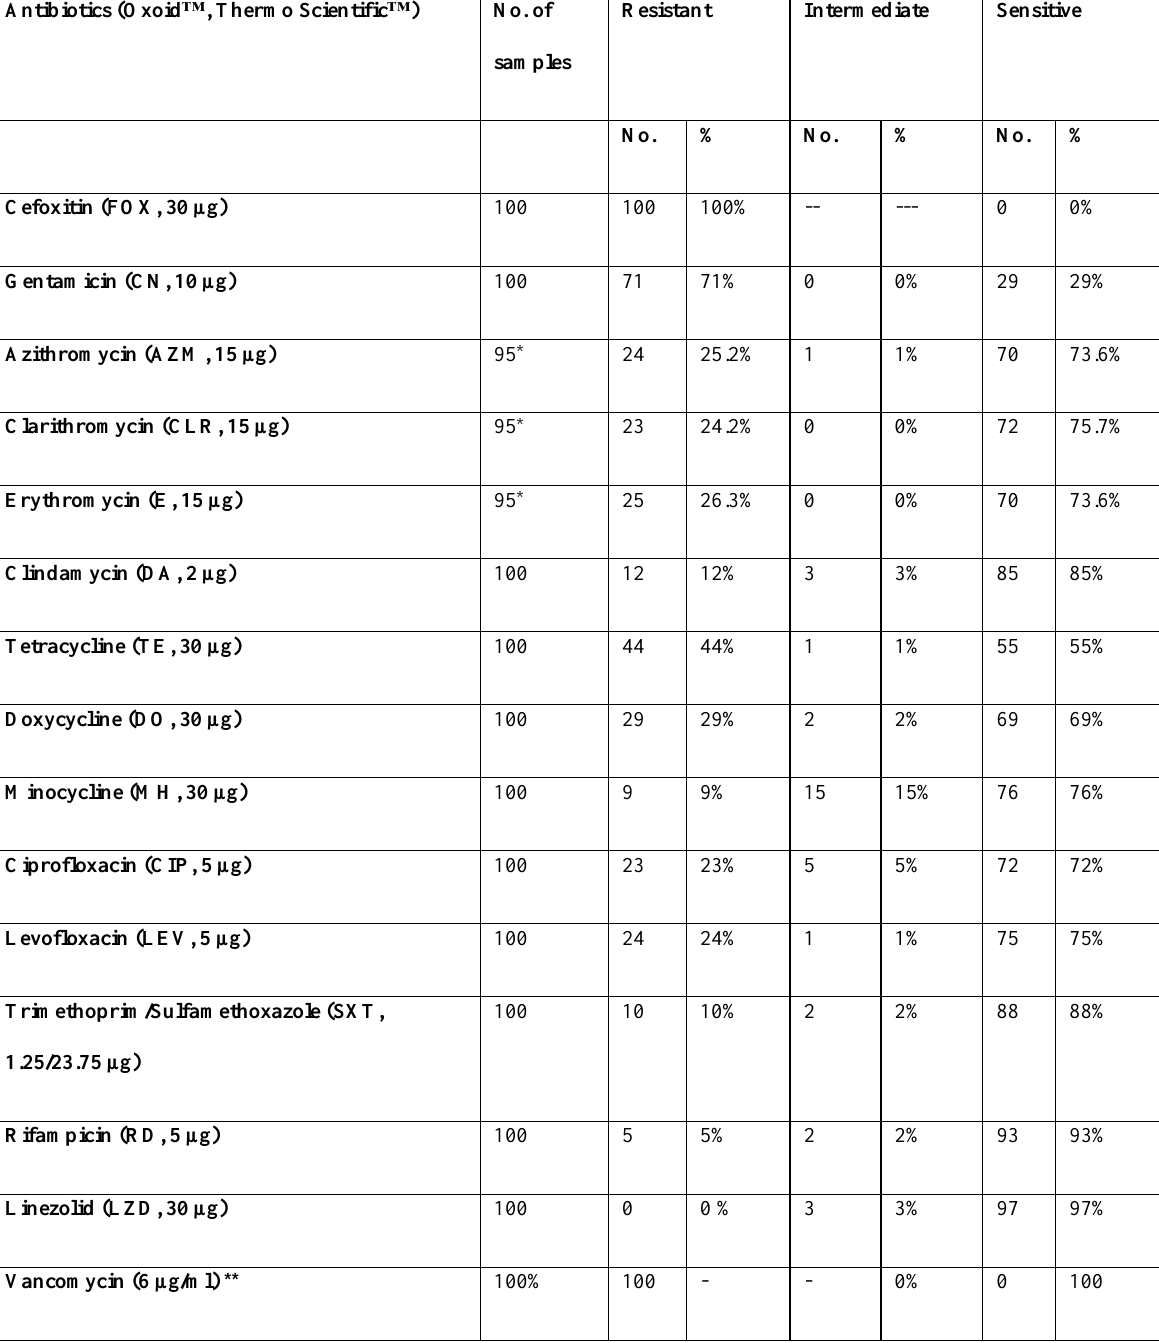
Table 2. Results of antibiotic susceptibility testing of the 100 MRSA isolates Antibiotics (Oxoid™, Thermo Scientific™) No. of